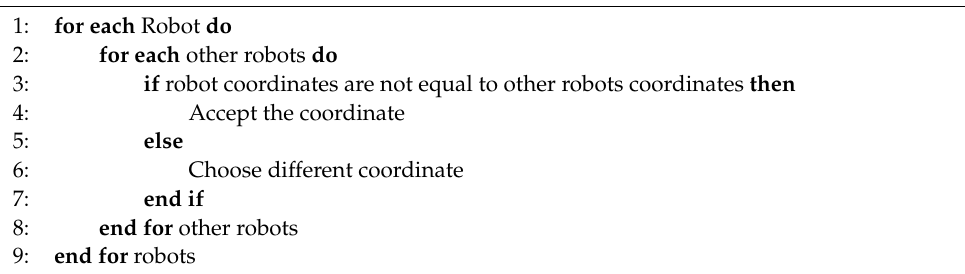
Algorithm 2 Solution 1: Conflict of Coordinates